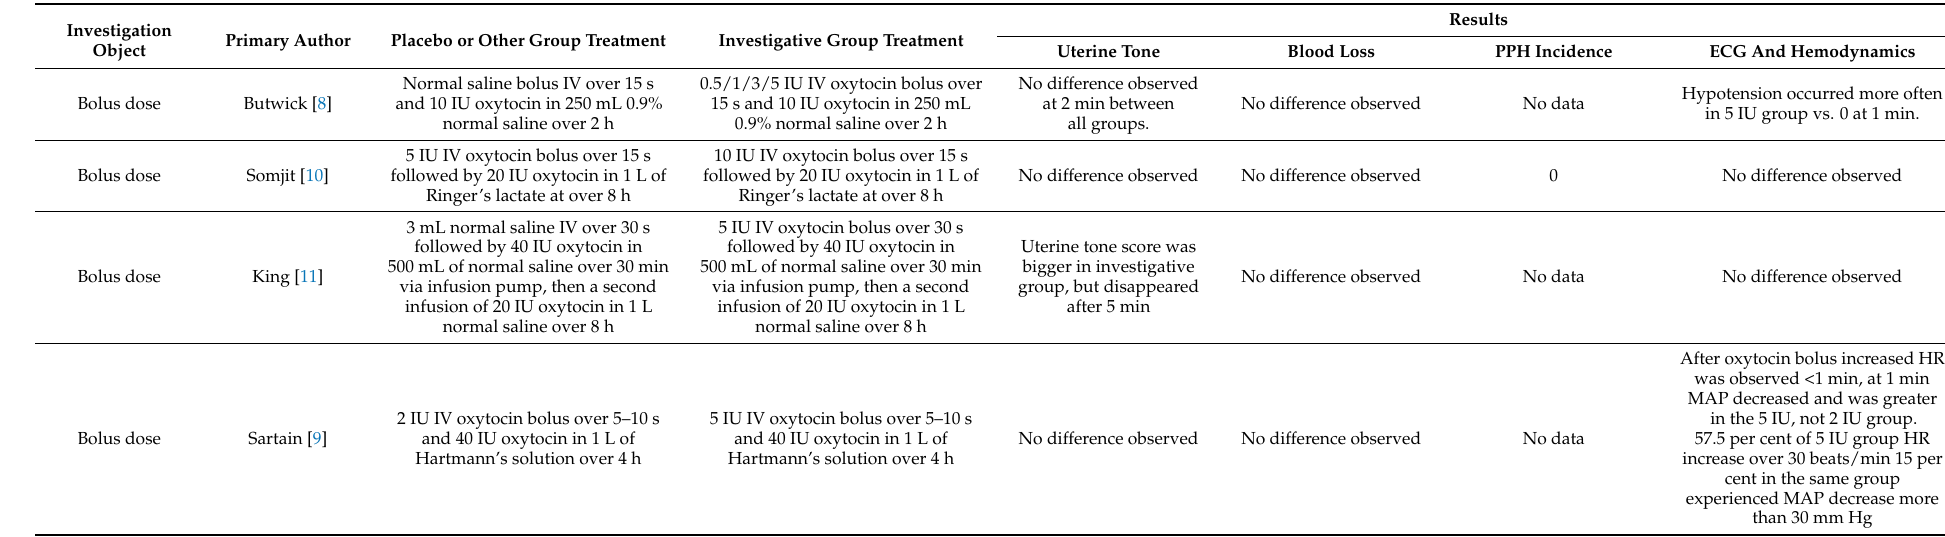
Table 2. Results of studies included in systematic